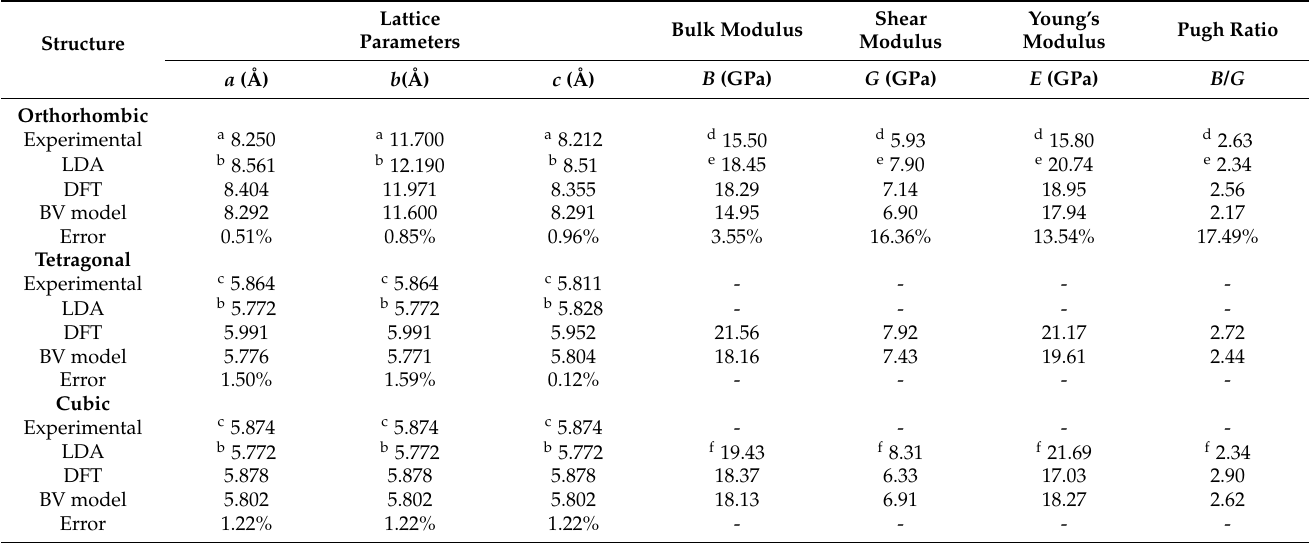
Table 2. Lattice parameters and elastic constants of orthogonal, tetragonal and cubic structures calculated through BV model, DFT method, LDA and